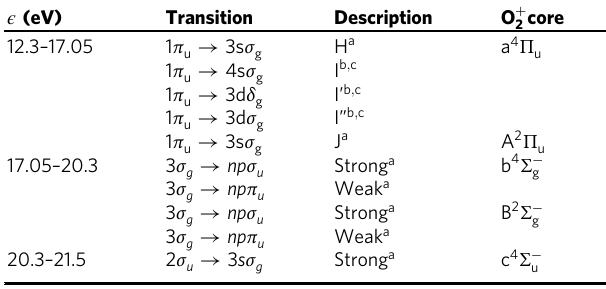
The experimental absorption spectrum of O 2 , shown in Fig. 3a, consists of numerous overlapping vibrational series associated with states of Rydberg and valence character. The absorptionfeaturesaresummarized bythephotonenergy ϵ ,thecolumn labeled “ Description"is the name of the electronic transitions in the “ Transition" column, the “ O 2 + core" column is the ionic state, to which the Rydberg series converge